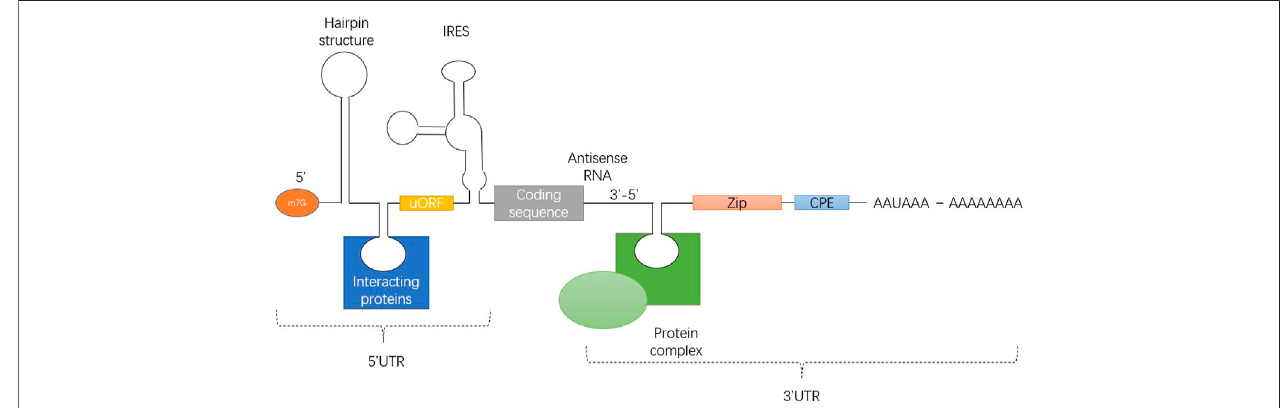
FIGURE 2 | Universal structure of eukaryotic mRNA, showing the structure of the 5 ’ and 3 ’ UTRs.